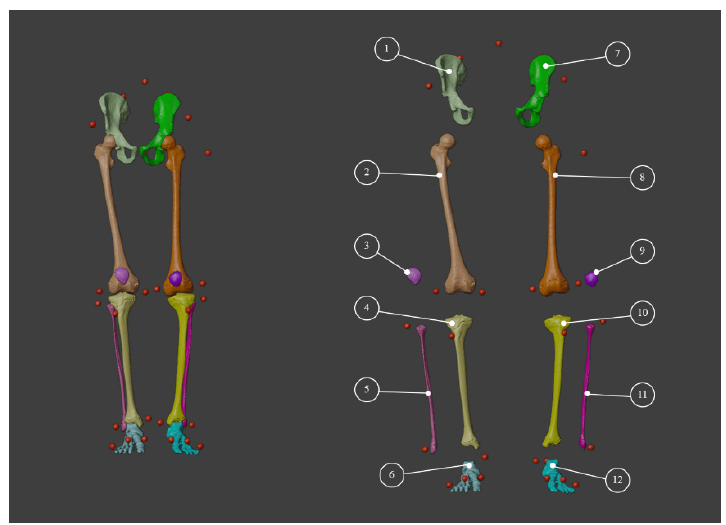
Figure 4. Bone separation using Blender.